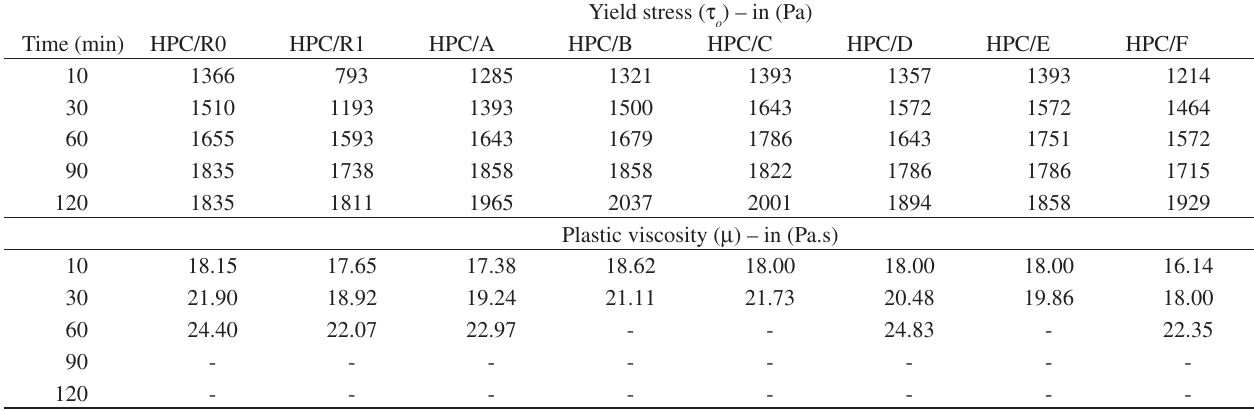
Table 5. Values of yield stress and plastic viscosity for evaluated concretes.